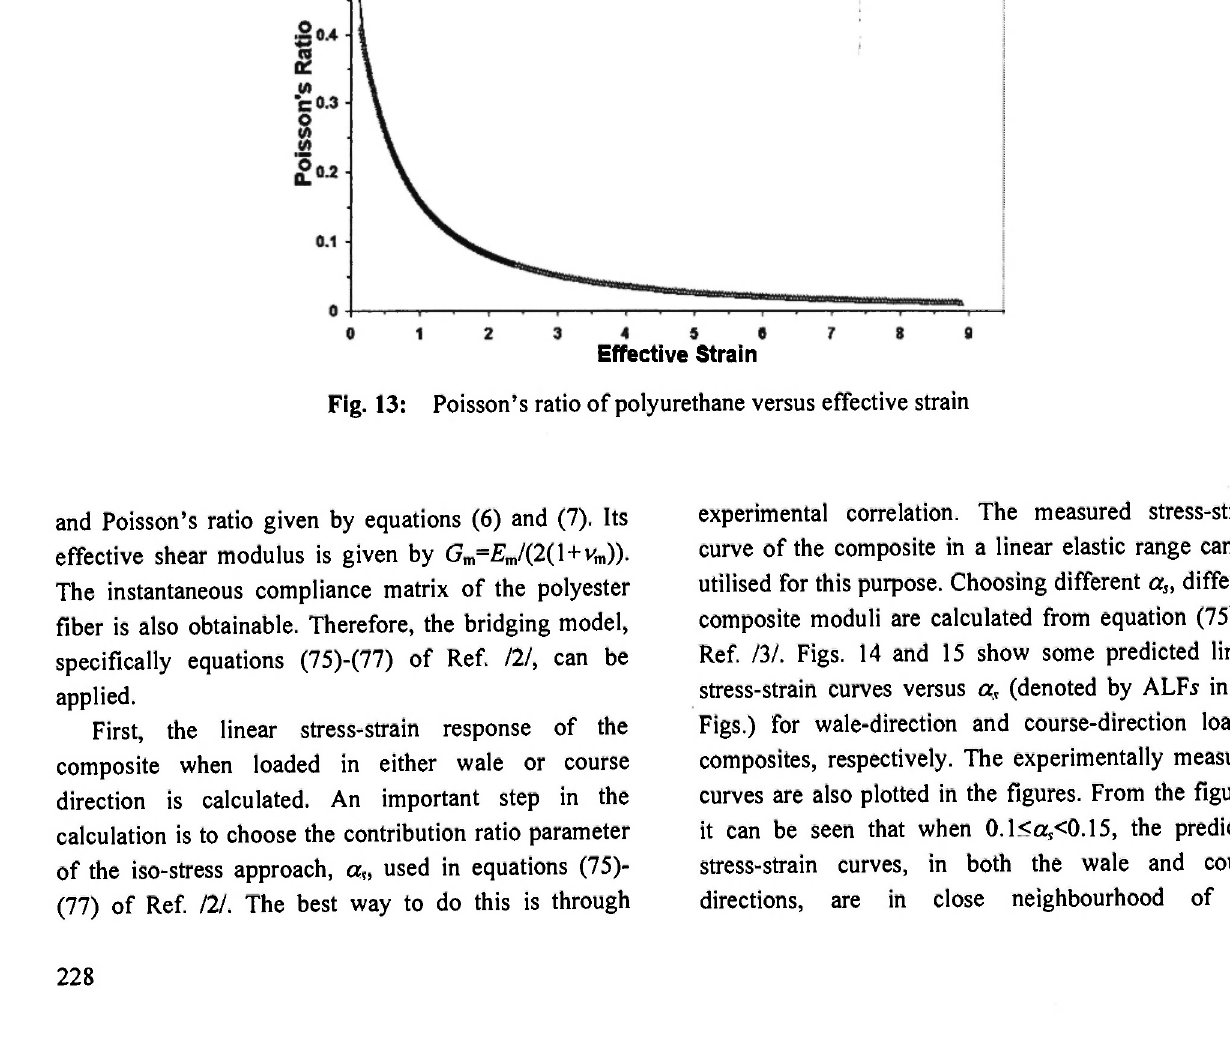
Fig. 12: Young's modulus of polyurethane versus effective strain